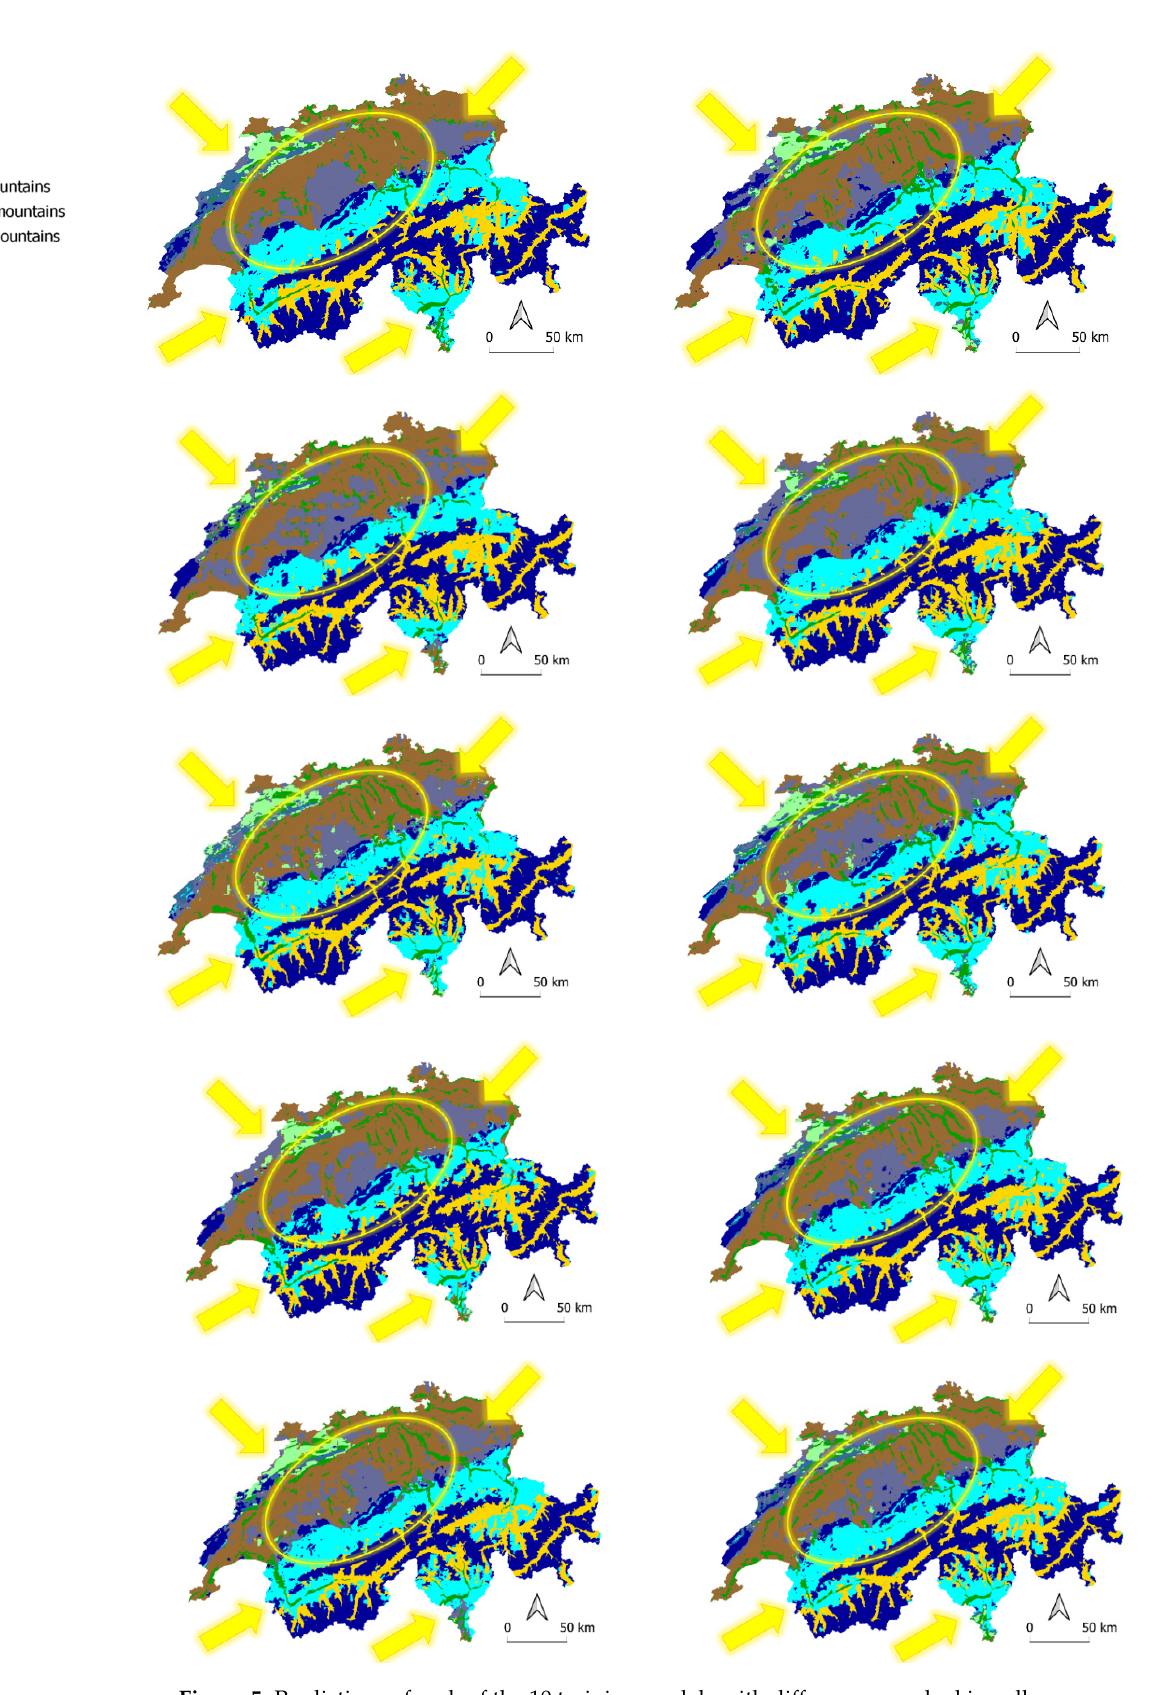
( b ) Figure 6. ( a ) Average predictions of the 10 models together, ( b ) ground-truth data. 3.2. Performance Assessment To evaluate and quantify the quality of predictions, we compute the following clas- sification metrics using the Scikit-learn library [22]—precision, recall, and f1 score [23]: •